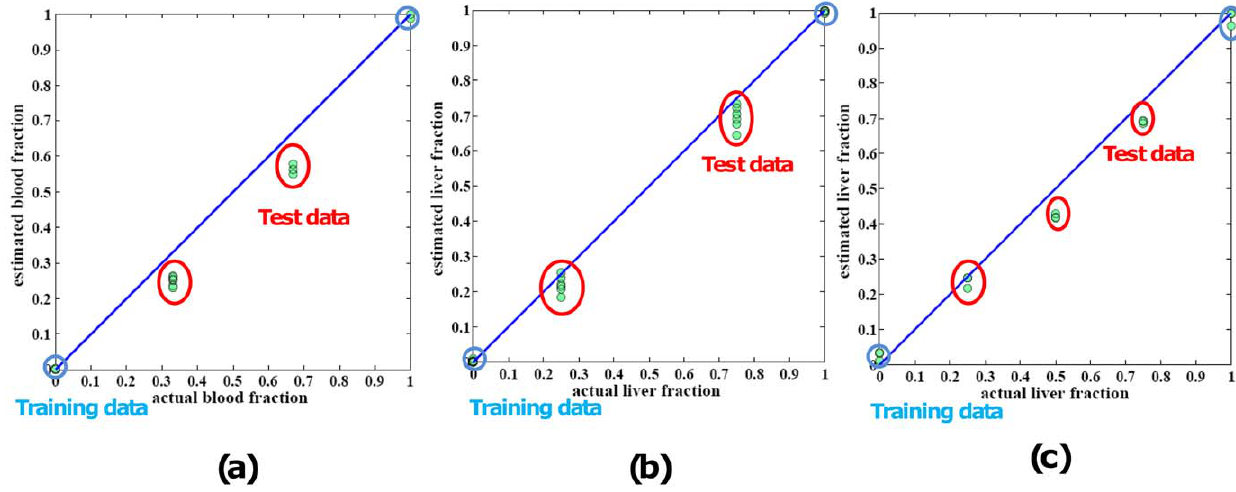
Figure 1. Statistical deconvolution of complex tissues yields accurate estimates of pure tissue fractions. Plotting of proportions of cell lines determined from deconvolution (y axis) vs . proportions of the cell lines actually mixed (x axis) shows strong congruity. (a) Proportions of blood cells determined by deconvolution are similar to proportions determined by actual blood fraction. Diagonal lines are y=x, shown for reference, highlighting the agreement between the two methods. The training data in blue circles are from pure reference samples. The test data are from mixed samples with various mixing proportions. (b) Proportions of liver fraction determined by deconvolution are similar to actual liver fraction. (c) Proportions of liver cell lines determined from deconvolution vs . proportions of the cell lines actually mixed are shown a high consistency in rat liver vs . brain dataset.